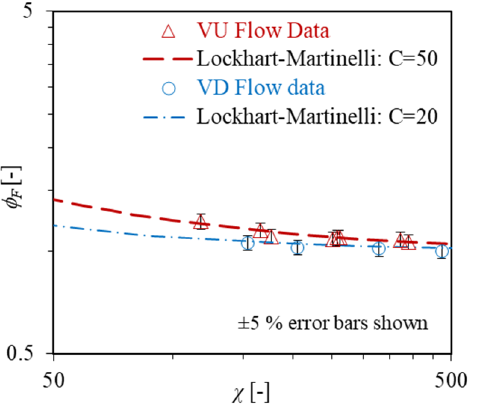
Figure 11. Frictional pressure loss analysis for VU and VD flows using the Lockhart–Martinelli cor ‐ relation.